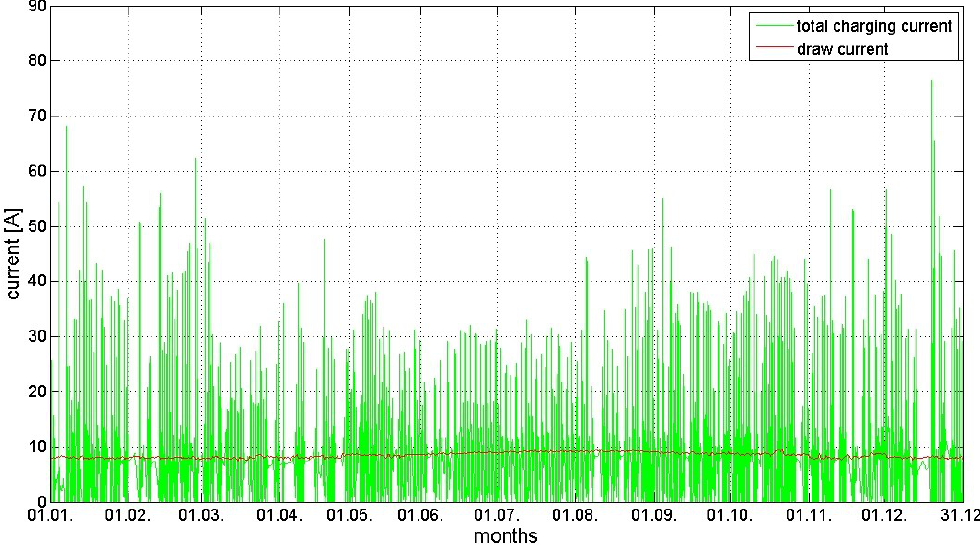
Figure 13. Interdependence of total charging and discharging current for the BSS C during one year.